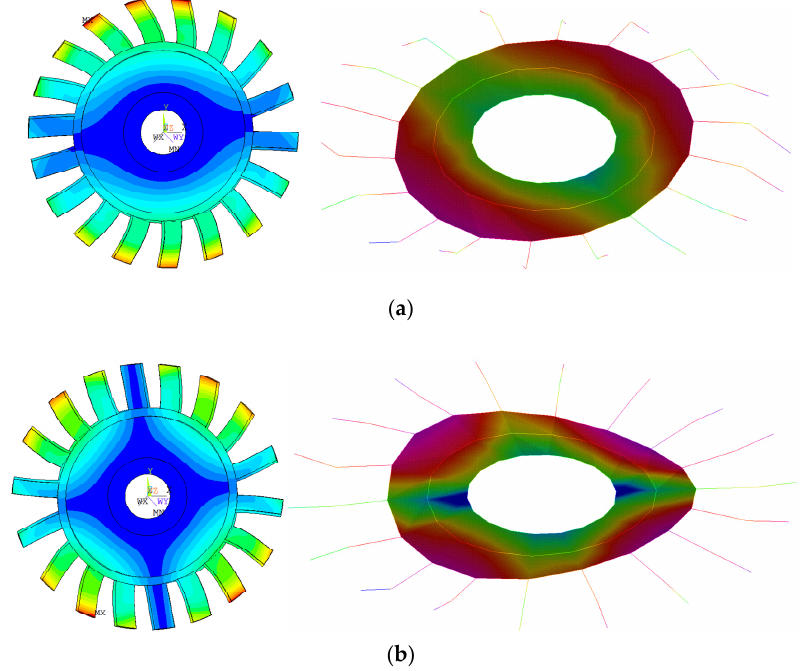
Figure 7. The comparison of mode shapes obtained from the ROM and the experimental test. ( a ) Mode shapes when nd = 1; ( b ) Mode shapes when nd = 2.